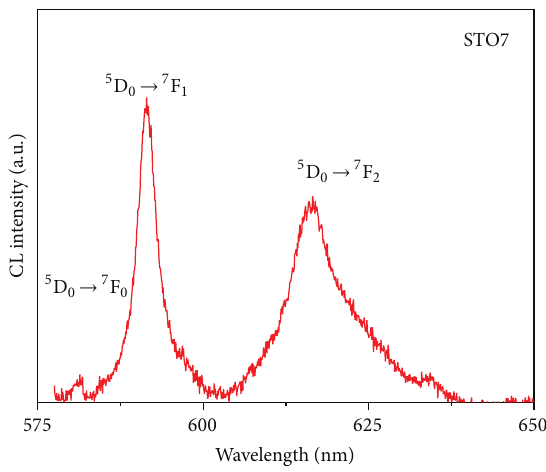
Figure 6: Cathodoluminescence spectra of sample